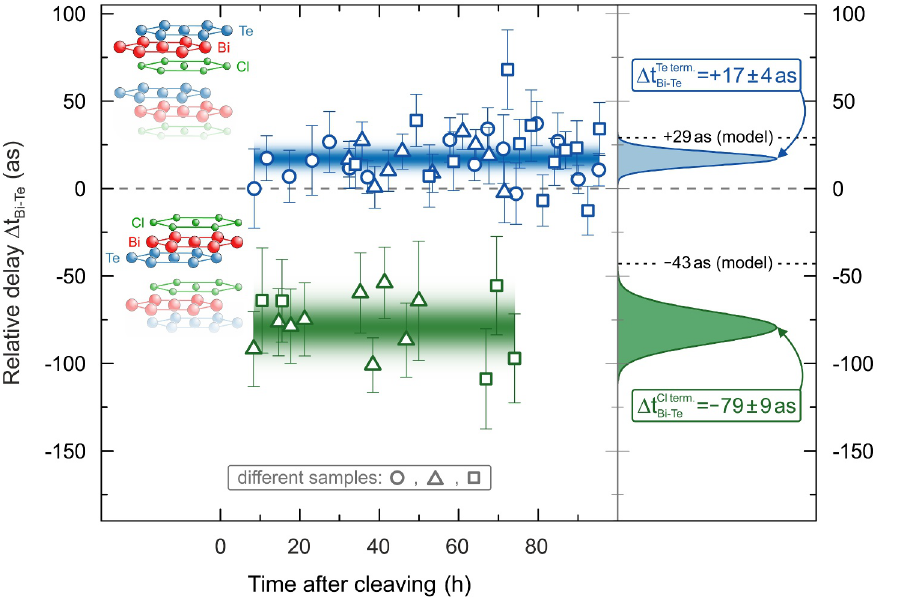
Fig. 1. Left panel: Experimentally observed relative streaking delays between the emissions from the core levels Bi-5d and Te-4d as a function of the time after cleaving for both surface terminations (Te-term.: blue, Cl-term.: green) and different samples ( 〇 , △ , □ ). Right panel: Comparison between the averaged delays from the left panel and the results from electron trajectory calculations (dashed